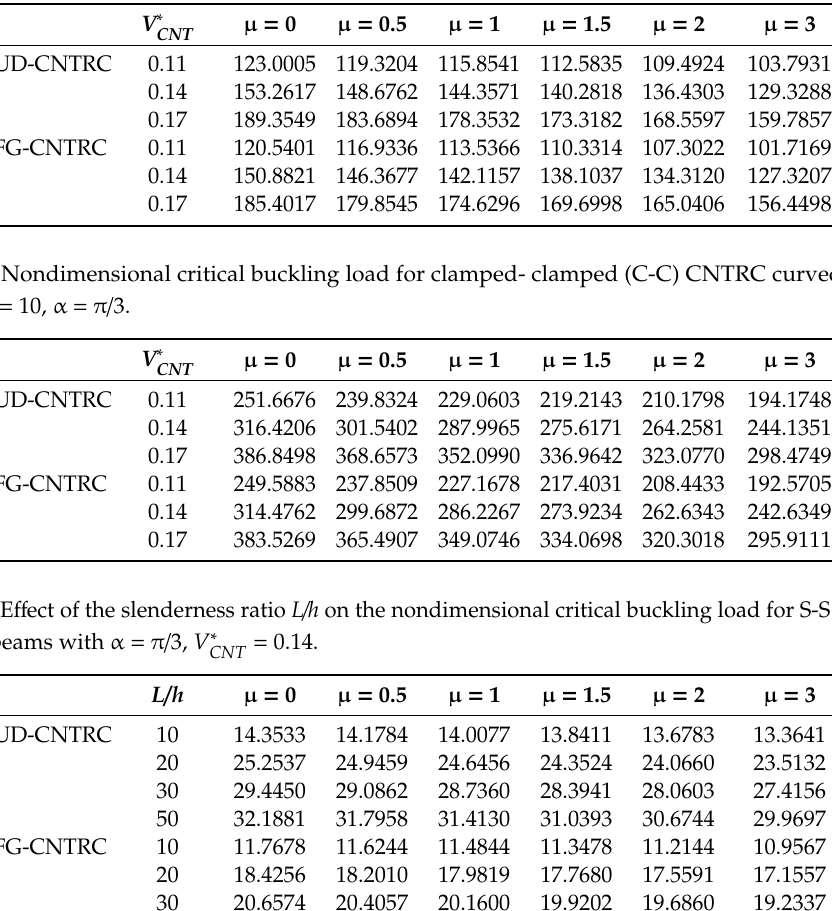
Table 4. Nondimensional critical buckling load for clamped simply (C-S) CNTRC curved beams with L / h = 10, α = π / 3.